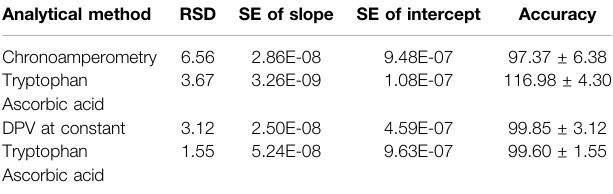
TABLE 3 | Validation parameters. Analytical